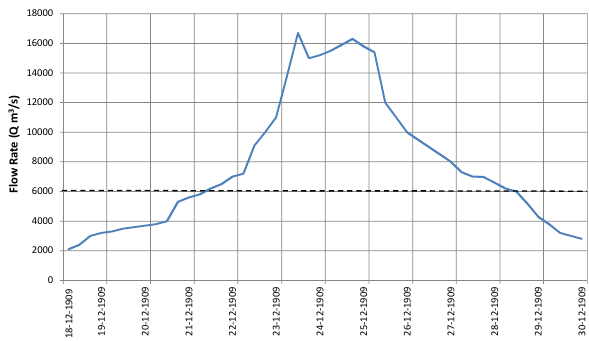
Figure 12. Flow rate (m 3 s − 1 ) at Peso da Régua from 18–30 De- cember 1909. Source: SNIHR (Rodrigues et al., 2003). The dashed line corresponds to an extraordinary flood at Peso da Régua (Portu-